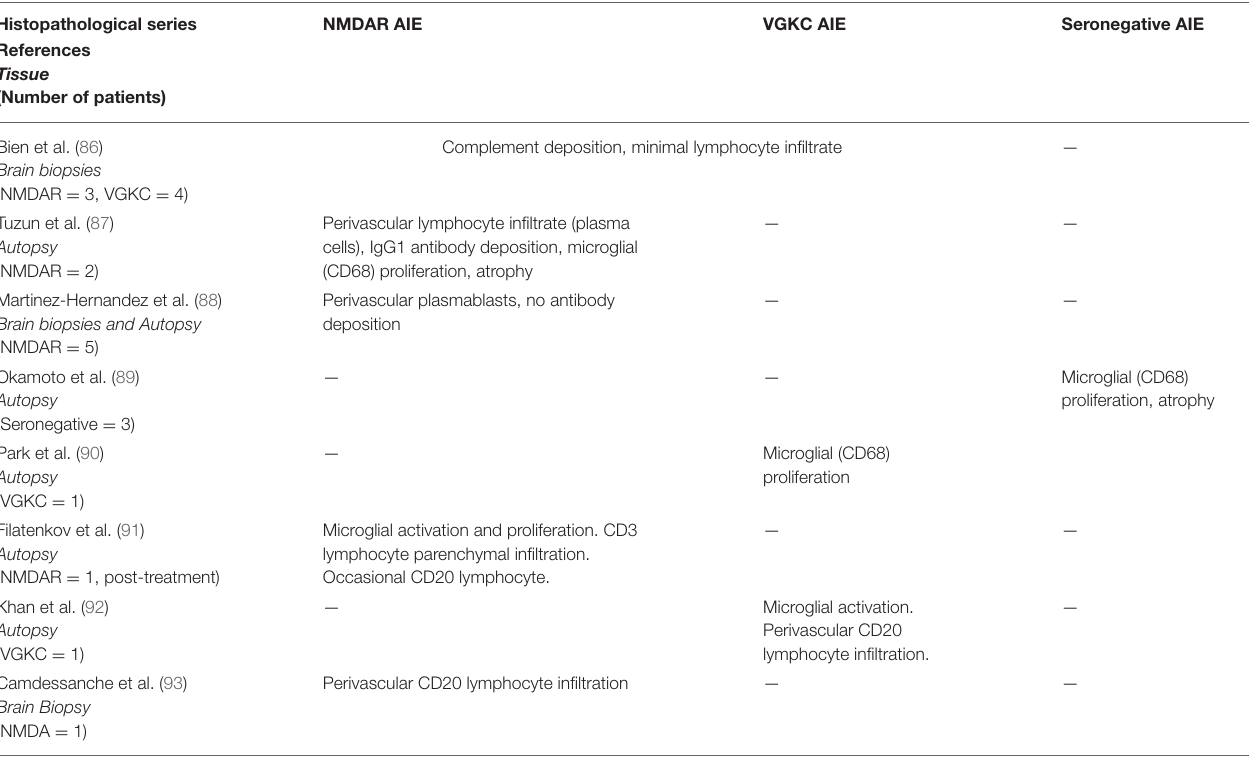
TABLE 3 | Histopathological studies in AIE. Histopathological